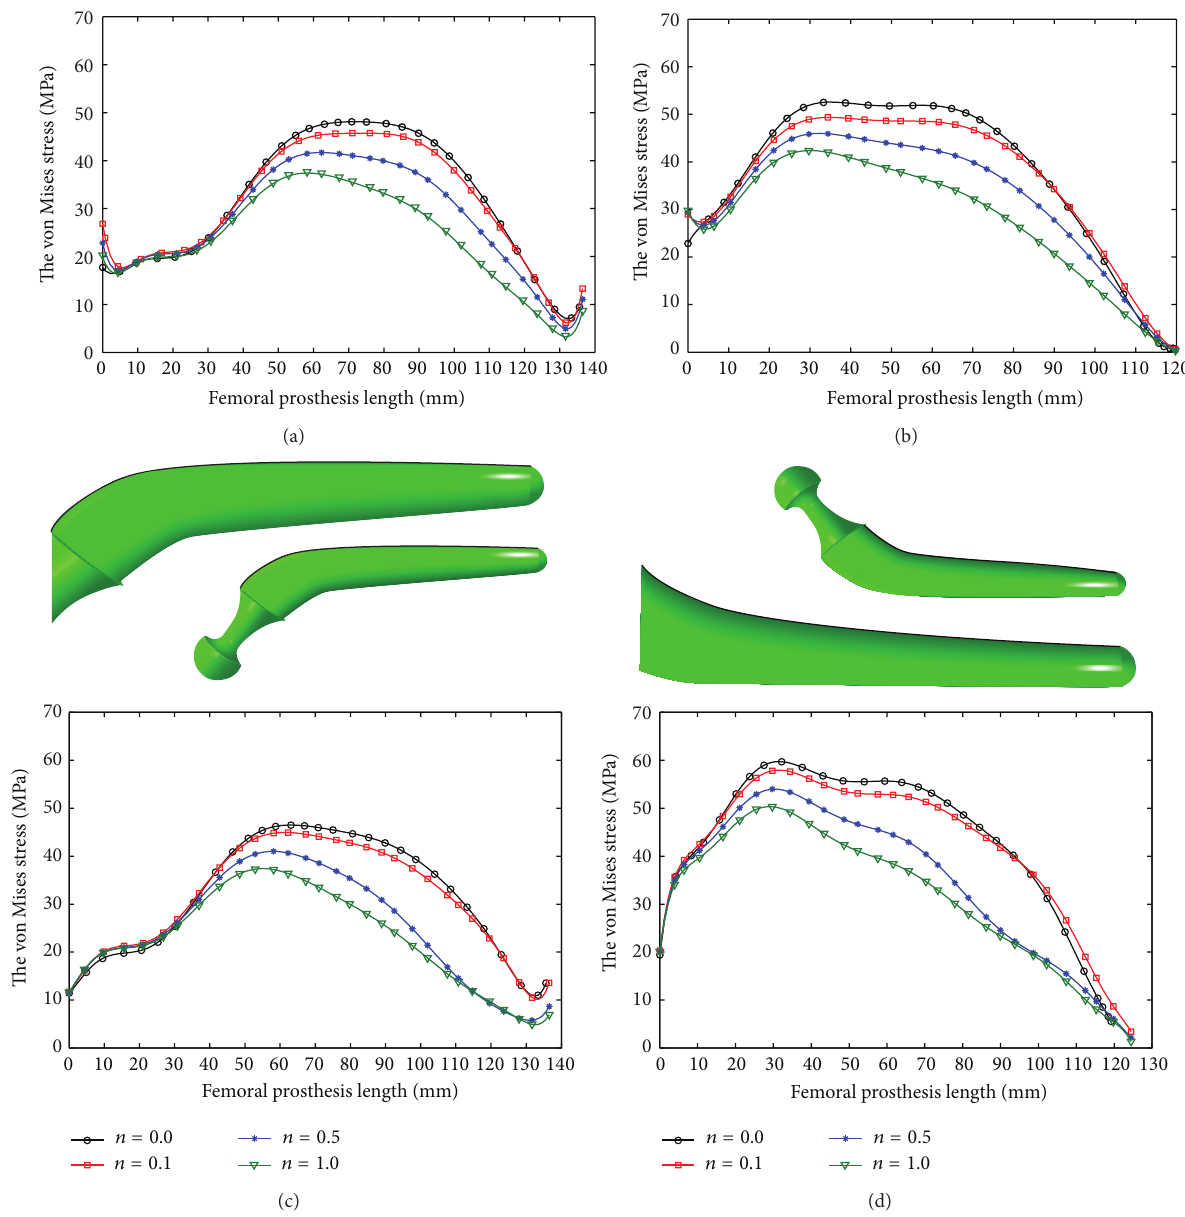
Figure 7: The von Mises stress variation on the longitudinal femoral prosthesis under normal walking: (a) lateral side of cemented prosthesis, (b) medial side of cemented prosthesis, (c) lateral side of noncemented prosthesis, and (d) medial side of noncemented prosthesis.